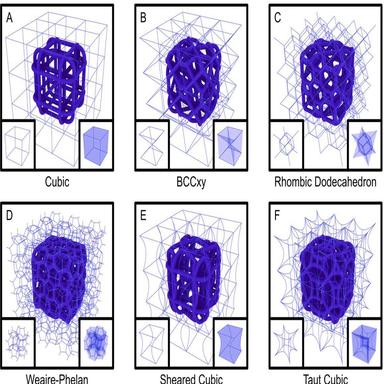
Visualization of unit cells and trimmed lattice structures for the geometries investigated and two demonstration geometries: (A) Cubic, (B) BCCxy (C) Rhombic dodecahedron (RD), (D) Weaire-Phelan (WP), (E) Sheared cubic, and (F) Taut cubic. Each panel includes the following: unit cell skeleton (inset, left), unit cell connectivity (inset, right), and tessellated unit cell and uniform lattice with skin (main). The rounded corners of the rectangular prism highlight the flexibility of the system to generate a u